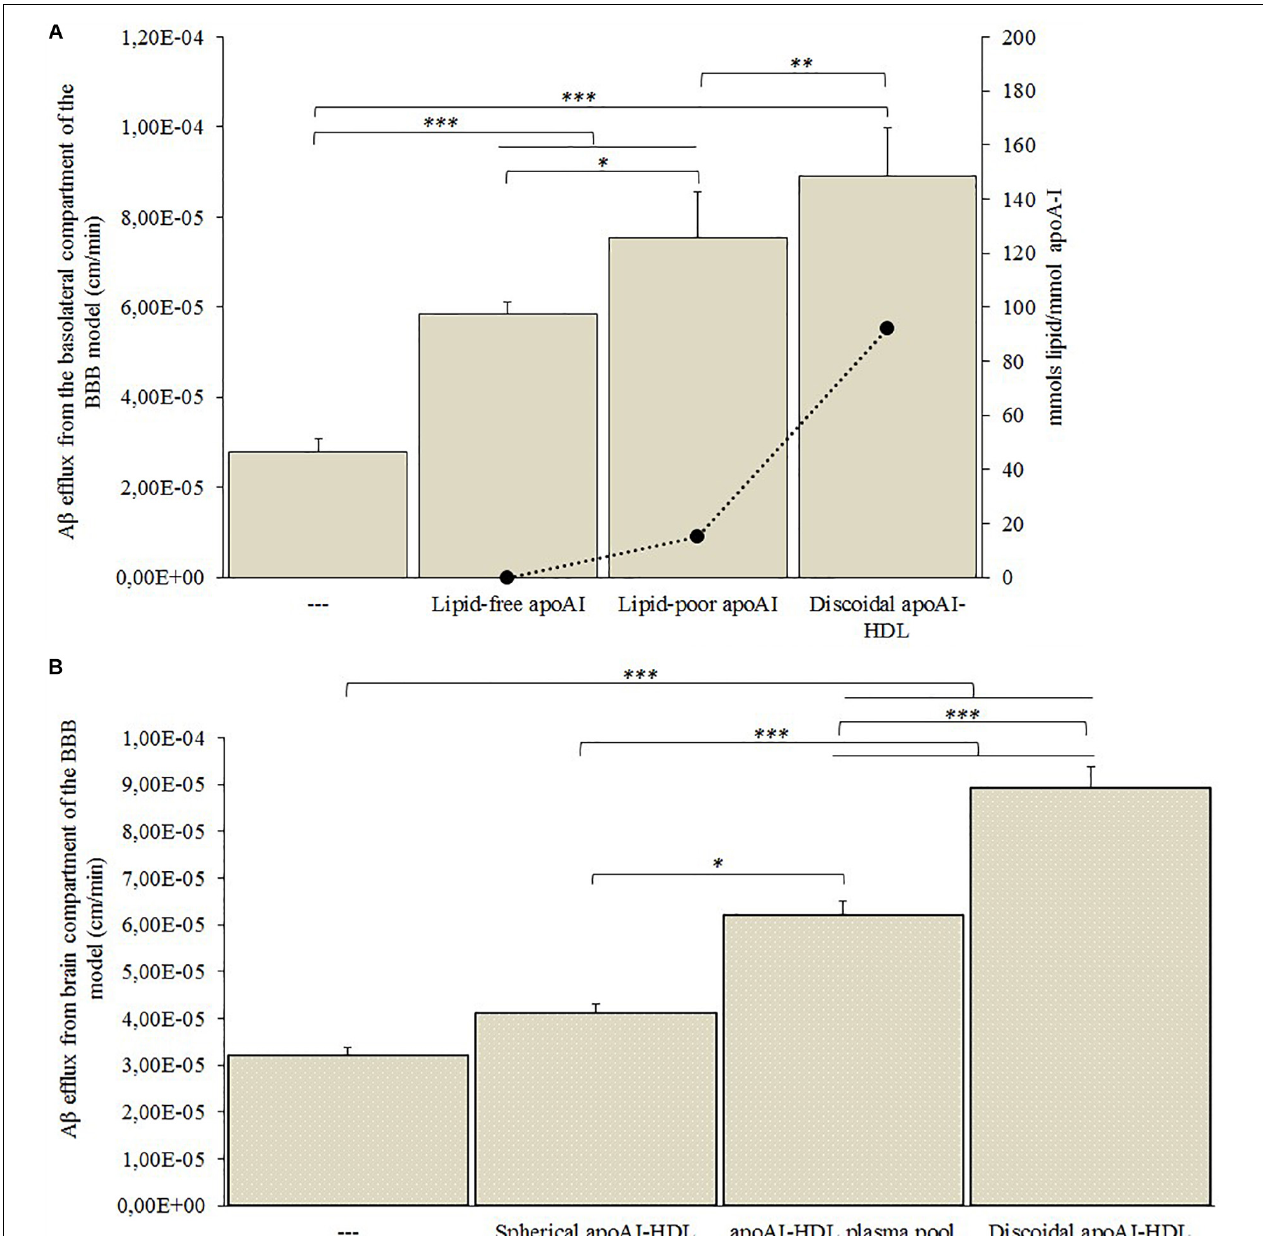
FIGURE 5 | A β efflux across the BBB model in the presence of human plasma-derived HDL. hCMEC/D3 cells were cultured on a transwell system and 500 nM of A β fibrils was added to the medium in the basolateral compartment. Different subclasses of HDL or A β -binding proteins were added to the apical compartment and the A β efflux from the basolateral compartment was measured by ELISA assay. (A) Endothelial permeability (EP) values of A β in the presence of lipid-free, lipid-poor or discoidal apoA-I, and the ratio of lipids to apoA-I in each sample. PBS alone in the apical compartment was used as a control (—). (B) EP values of A β in the presence of spherical apoA-I-HDL, apoA-I-HDL plasma pool or discoidal apoA-I-HDL. PBS alone in the apical compartment was used as a control (—). Data were expressed as endothelial permeability (EP), reported as the mean ± SEM of triplicate experiments. One-way ANOVA found significant differences (A) F ( 3 , 32 ) = 87.47; p = 0.00001; (B) F ( 3 , 32 ) = 120.61; p = 0.00001. ∗ p < 0.05, ∗∗ p < 0.01, ∗∗∗ p < 0.01 by Tukey’s post hoc